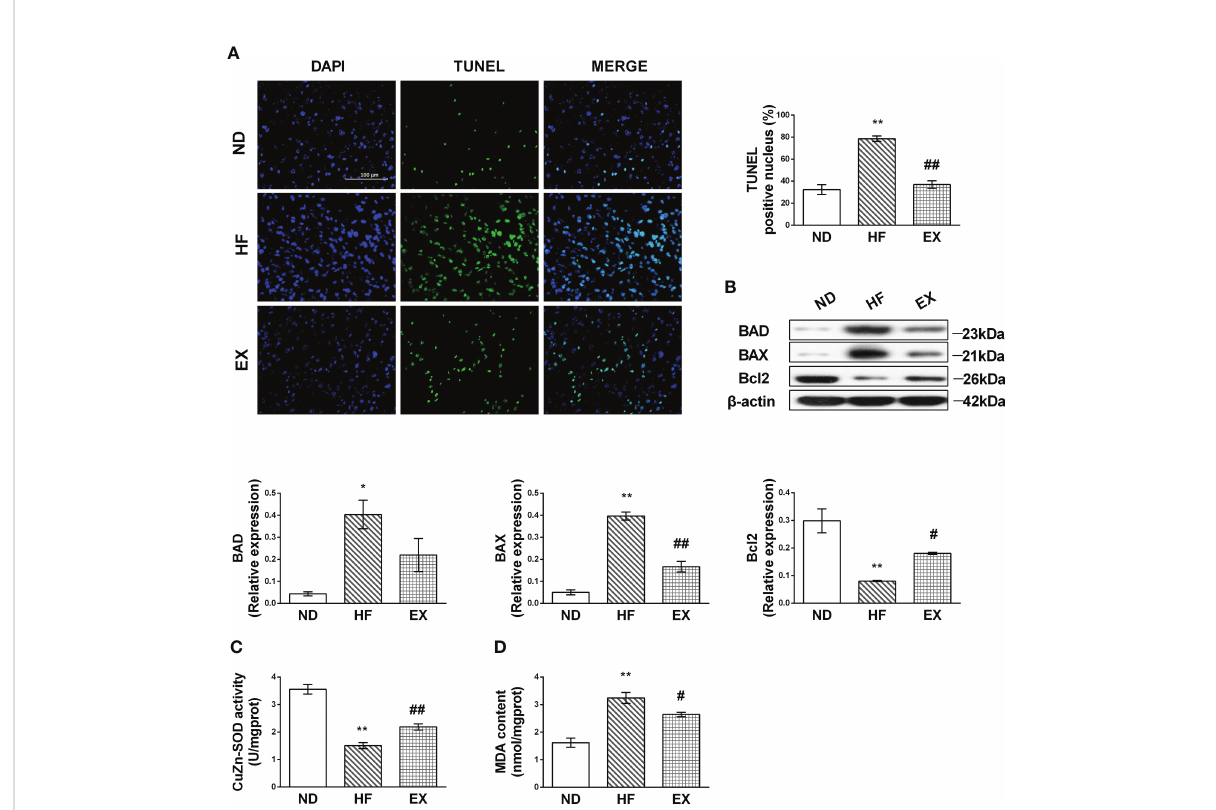
FIGURE 2 Exercise protects against hepatic lipotoxicity induced by 16 weeks of high-fat diet feeding. Representative images of liver sections stained with TUNEL (A) and the number of TUNEL-positive cells in liver sections ( n = 3 per group). Hepatic protein expression of BAD, BAX, and Bcl2 (B) by Western blot analysis and graphs of their quanti fi cation. Quanti fi cation of immunoblots is shown in the graphs. ( n =3 per group). CuZn-SOD activity and MDA content in the liver tissue sample (C, D) . M ± SEM; * P < 0.05 versus ND; ** P < 0.01 versus ND; # P < 0.05 versus HF; ## P < 0.01 versus